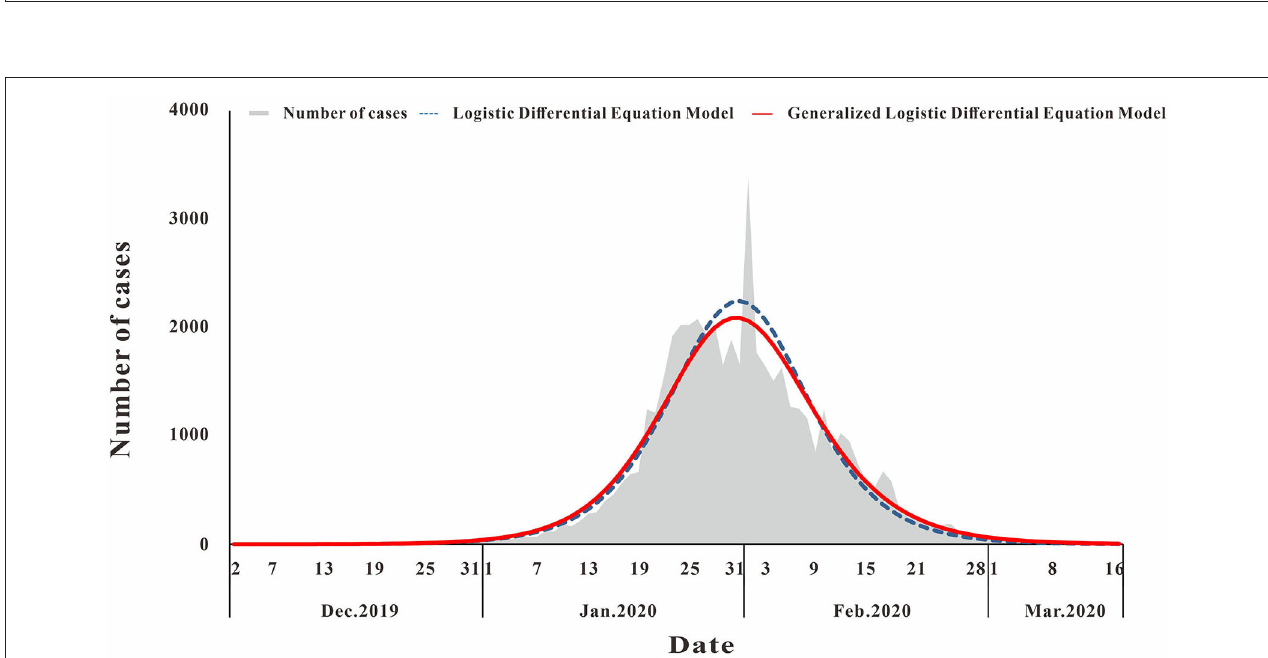
Frontiers in Public Health |